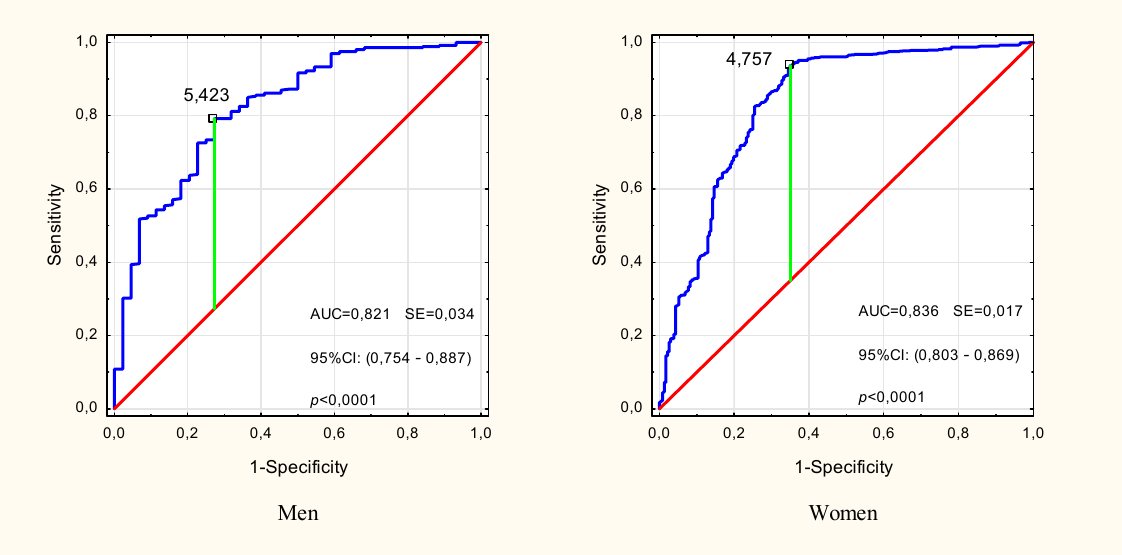
Figure 3. ROC curve for impedance phase angle in identifying pre-sarcopenia in males and females over the age of 50. The marked point is the cut-off point for the pre-Sarcopenia state. ROC—receiver operating characteristic, AUC—area under the ROC curve, SE—standard error, 95% CI—confidence interval.